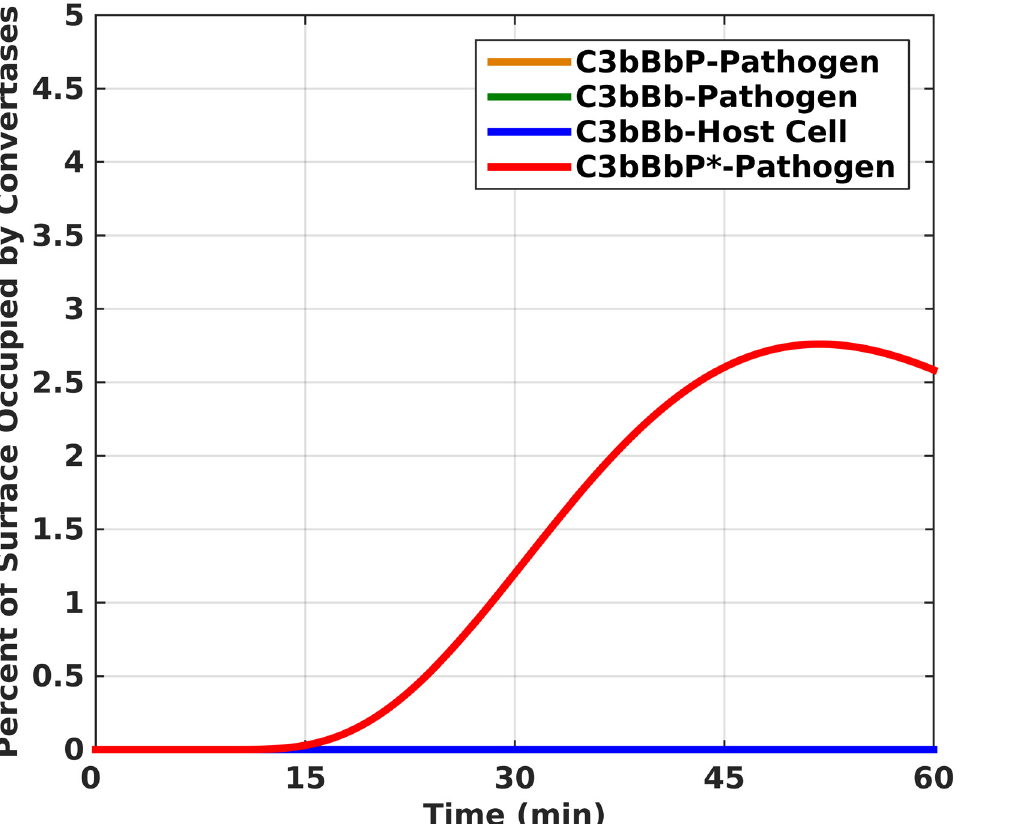
Fig 4. Formation of C3 cleaving enzymes on the surface of host cells and pathogens. C3bBbP * occupies 2.7 percent of the pathogen surface in 51 minutes. The asterisk denotes properdin released from neutrophils. The time profile of C3bBbP * shows a curve with a lag phase followed by an accelerated production (surface occupational) phase. The production of C3bBb and C3bBbP occupies significantly less than 1 percent on pathogens and even less on host cells. The orange and green lines are obscured by the blue line in the